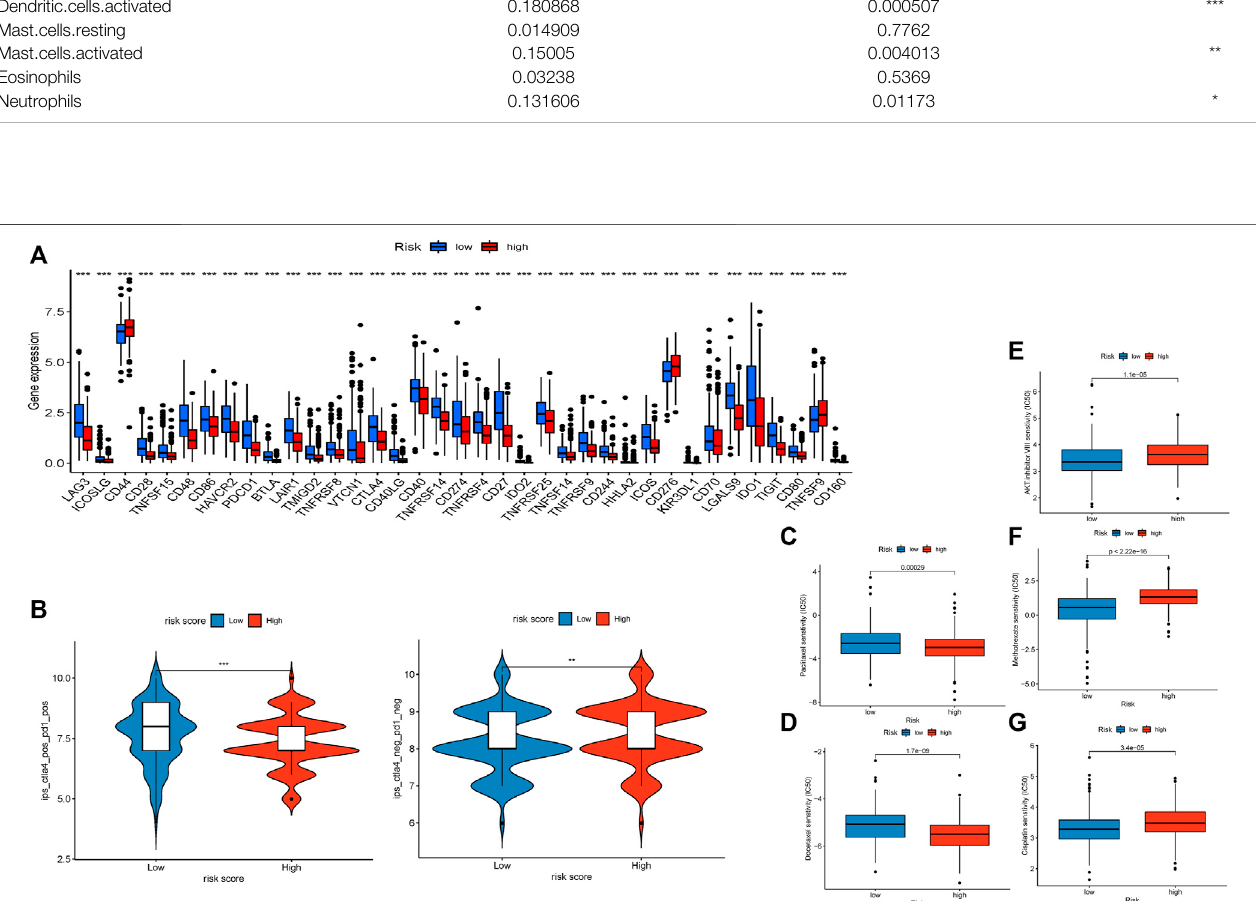
Frontiers in Cell and Developmental Biology |